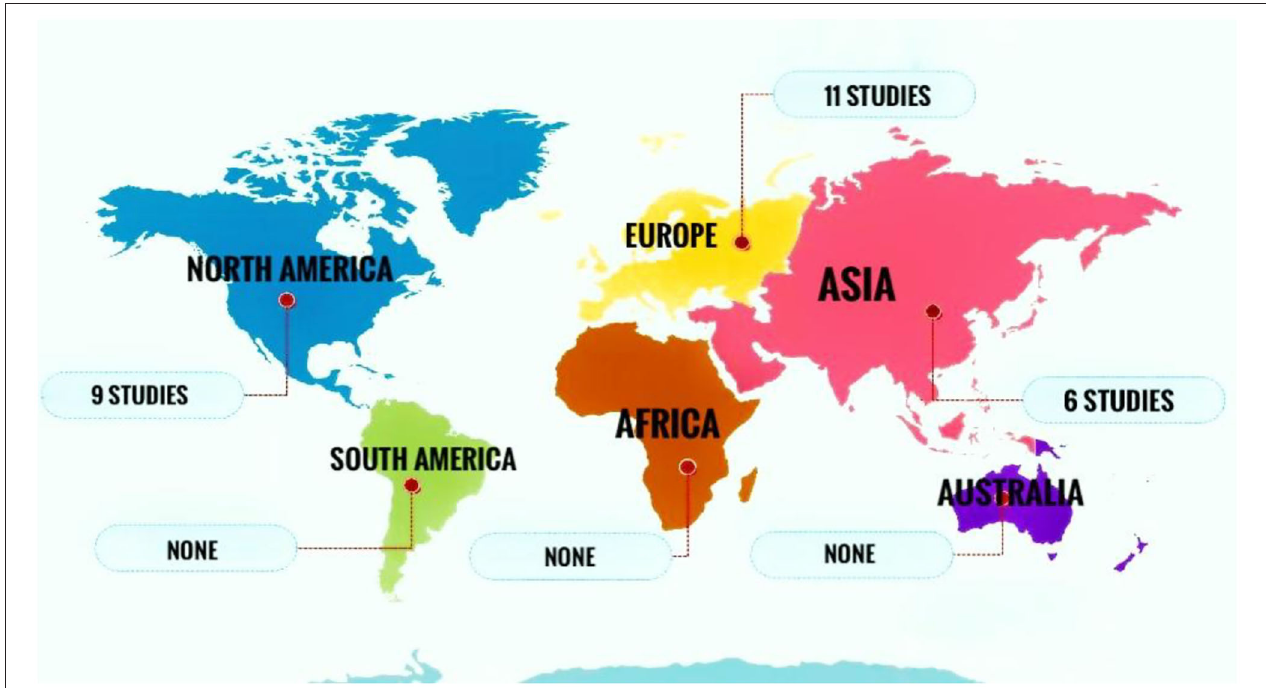
FIGURE 2 | Several studies conducted in different continents reporting data on the effect of the anteroom (vestibule) area in controlling hospital